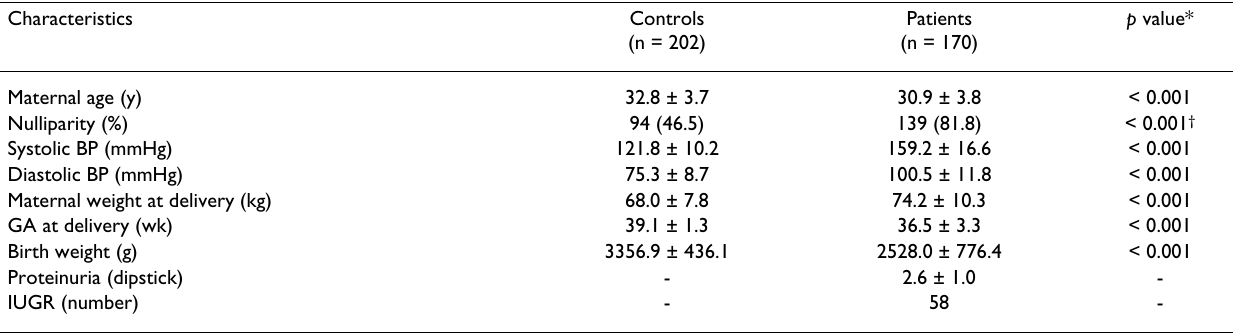
Table 1: Clinical characteristics of normal controls and preeclamptic patients